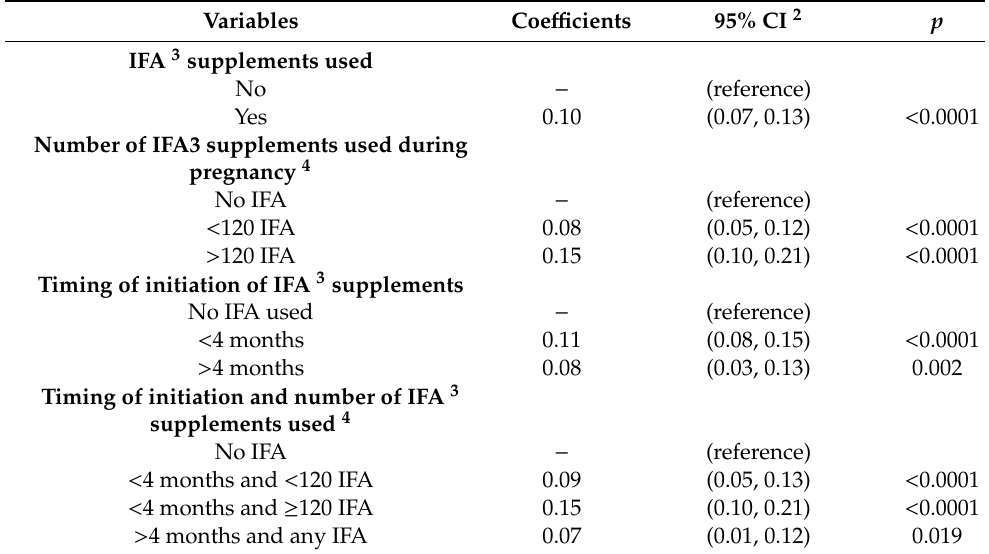
Table 8. E ff ect of any iron / folic acid (IFA) supplementation, the number of supplements used, the timing of the start of supplements and a combination of the timing of start with the number of supplements used on the length-for-age Z score in south Asian children < 2 years old, adjusted linear regression 1